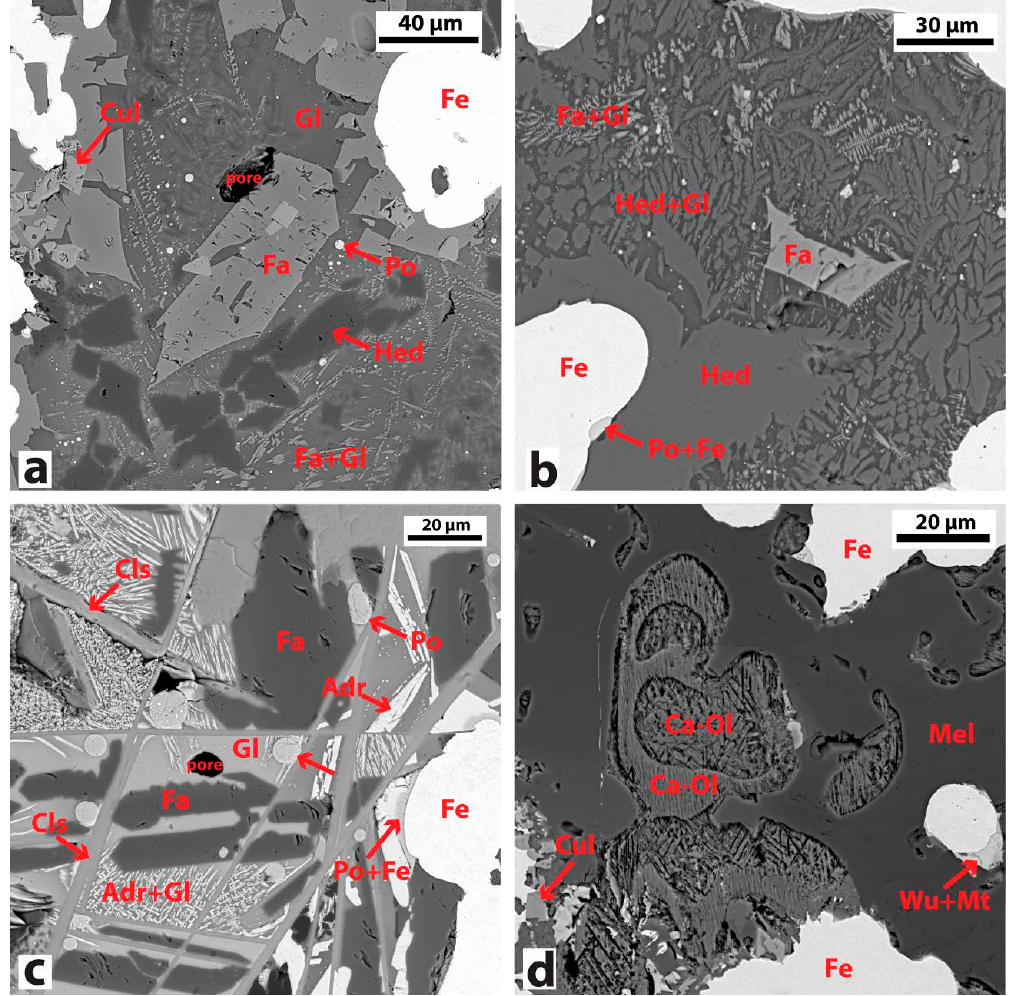
Figure 9. Typical microstructures of slag from W CB . SEM-BEI. ( a ) Negev-6. Slag composed of large prismatic crystals of fayalite (Fa), large twinned hedenbergite (Hed), coulsonite (Cul), prills of pyrrhotite (Po) in a matrix of glass (Gl), and fayalite microlites; ( b ) Negev-3. Slag composed of euhedral crystal of fayalite, massive crystals of hedenbergite in a microlitic matrix of glass, hedenbergite, and fayalite. Pyrrhotite-metal eutectics (Po + Fe) is locally present; ( c ) Negev-5. Slag composed of large euhedral crystals of fayalite, needles of celsian (Cls) grown through fayalite with shear deformation, laths and dendrites of andremeyerite (Adr), prills of pyrrhotite, and localized pyrrhotite-metal eutectics; ( d ). Negev-2. Twinned calico-olivine (Ca-Ol), euhedral coulsonite in a microlitic matrix of melilite (Mel). Wusite-magnetite ex-solutions are locally